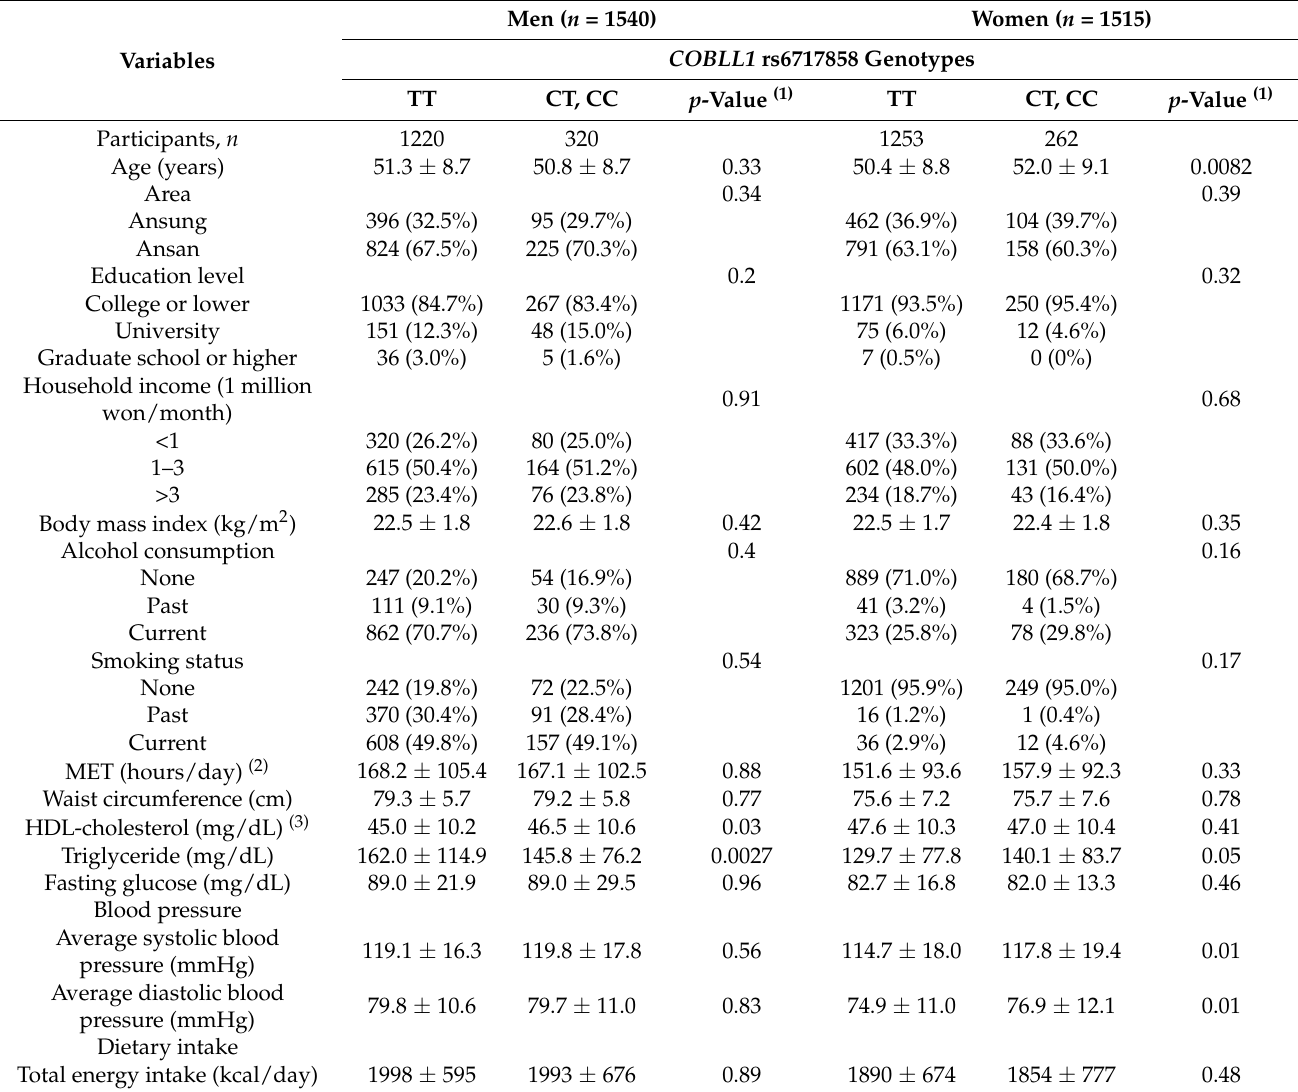
Table 2. General characteristics, biomarkers, and dietary intake of study participants based on sex and COBLL1 rs6717858